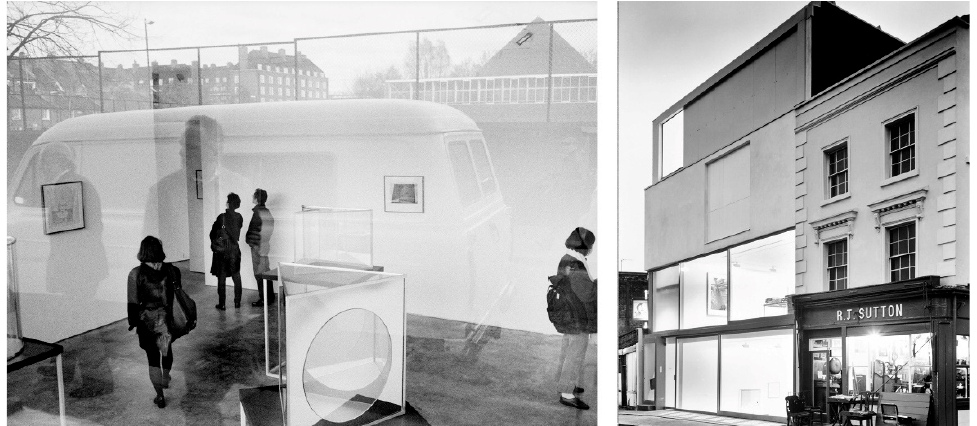
Figure 4. Lisson Gallery, London, 1992, Tony Fretton. © Chris Steele-Perkins. Magnum photos.